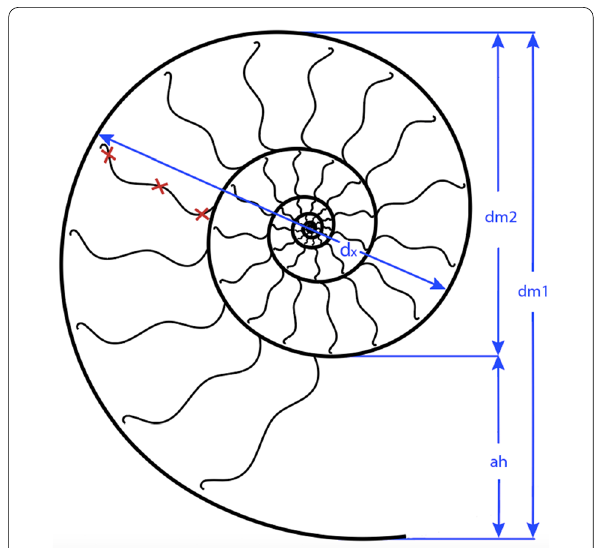
Fig. 6 Descriptive terms for conch morphology in longitudinal section. dm1: whole diameter. ah: apertural height, dm 2 dx: Diameter at a specific septum. Red crosses stand representative for the three thickness measurement points at each septum. Descriptive terms after Korn (2010)